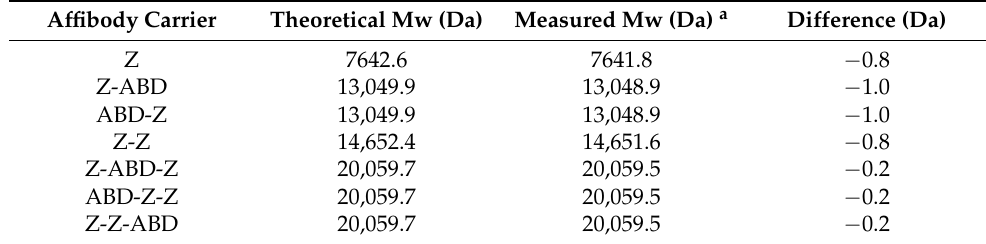
Table 1. Theoretical and measured values of the proteins’ molecular weights.